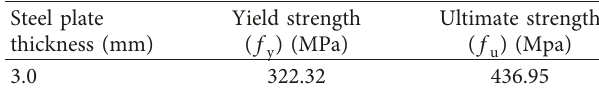
Table 4: Properties of steel